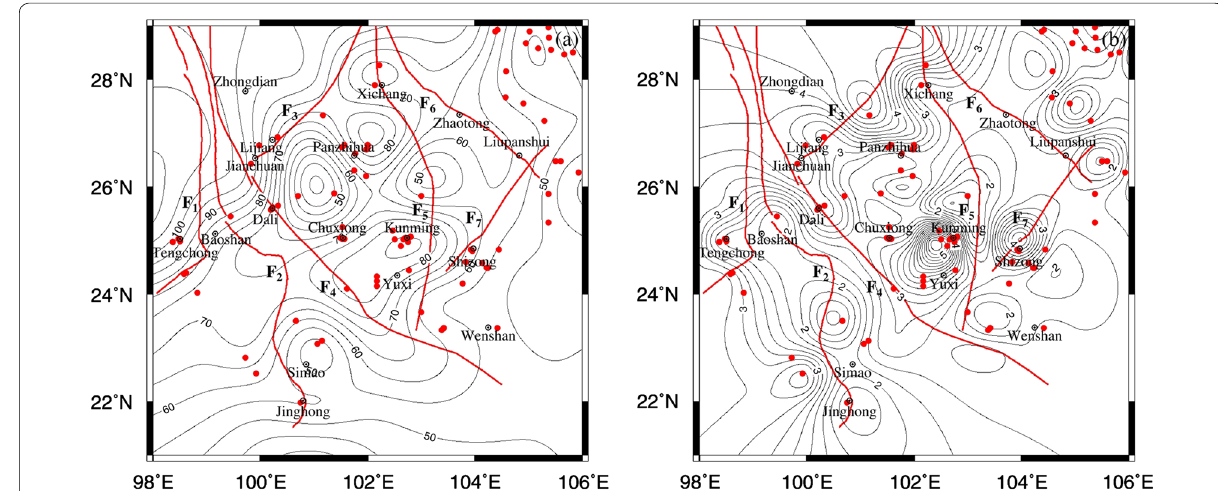
Fig. 4 Distribution of a surface heat flow and b thermal conductivity